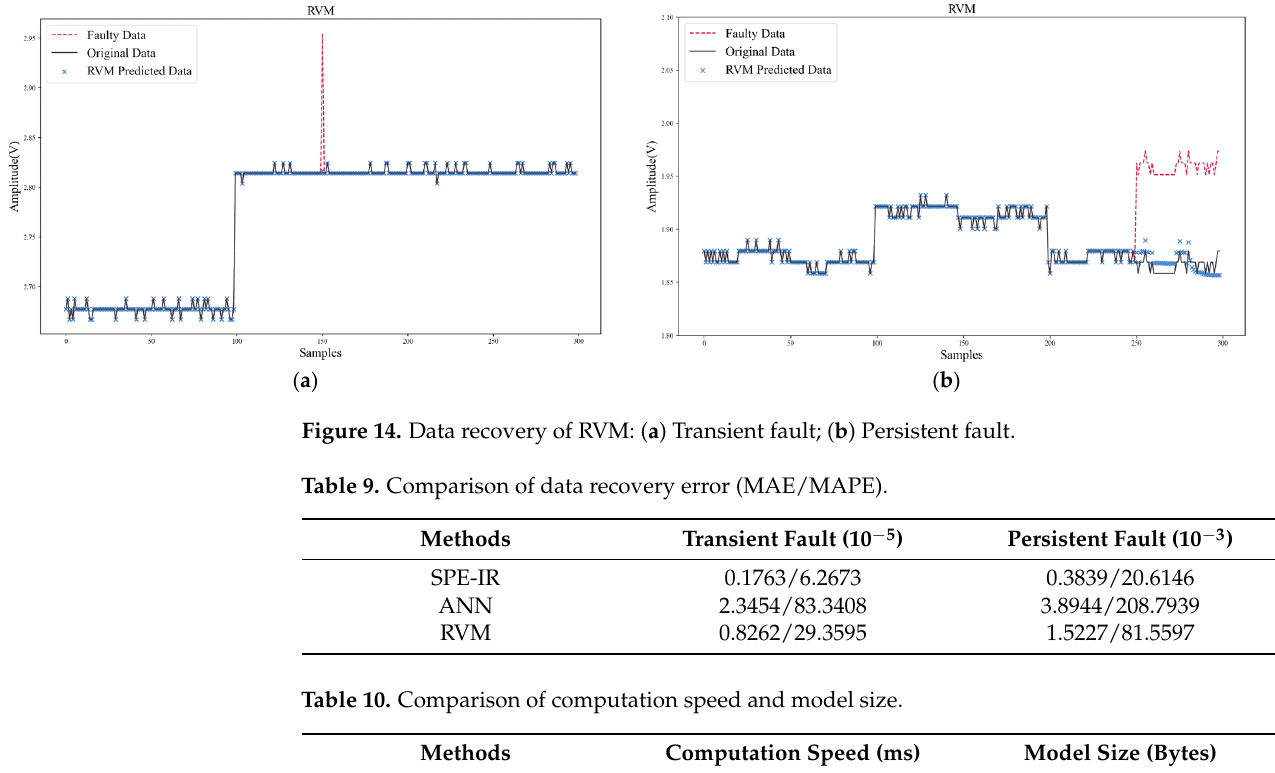
Figure 13. Data recovery of ANN: ( a ) Transient fault; ( b ) Persistent fault.